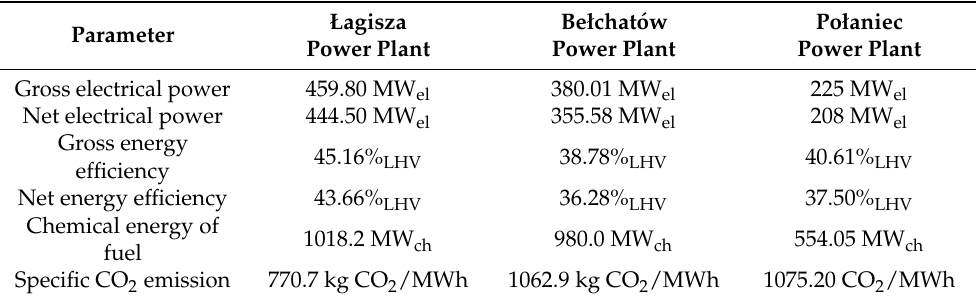
Table 1. Technical summary of analyzed Polish power plants.